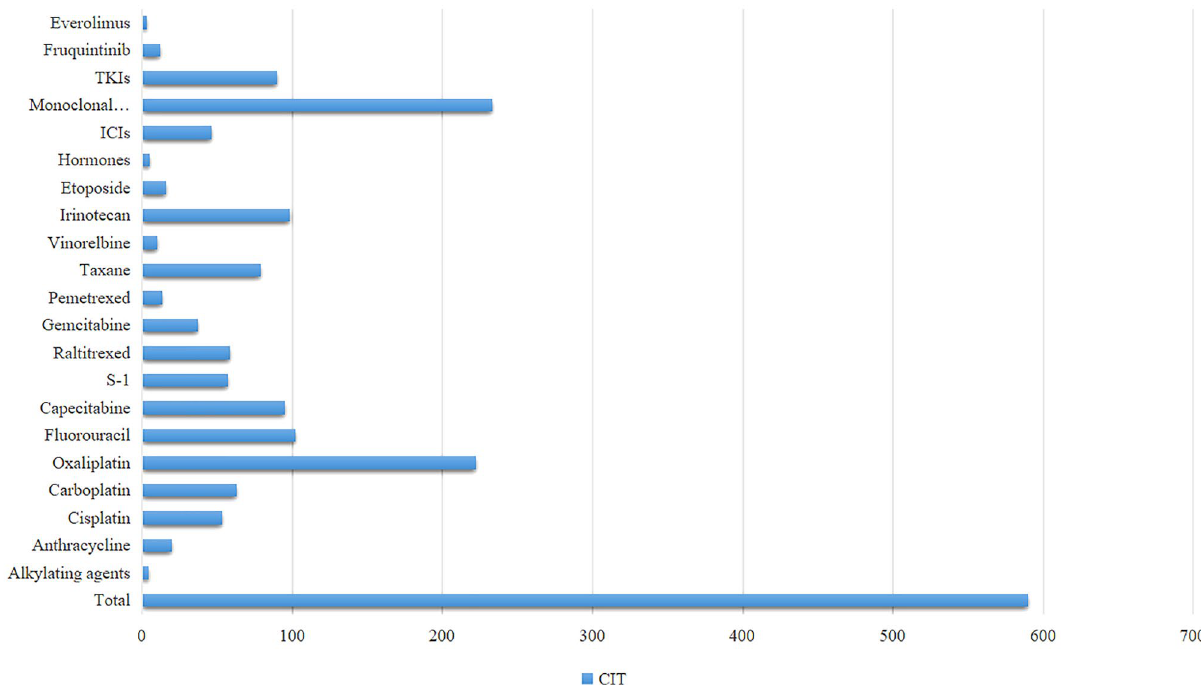
Figure 3. Cumulative number of CIT based on chemotherapy cycles by antineoplastic